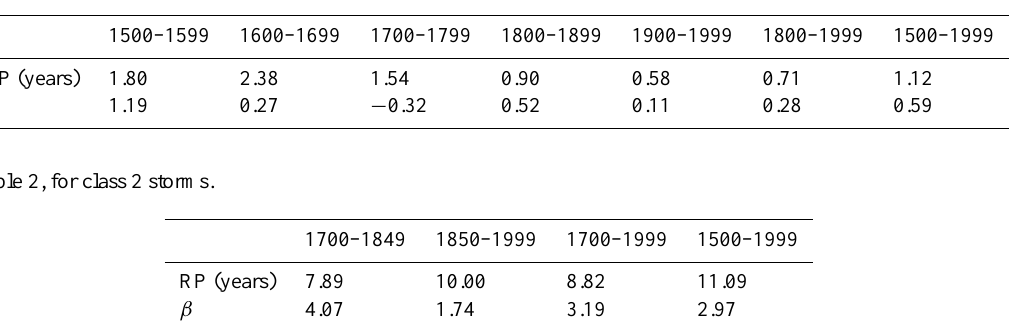
Figure 9. Clustering strength ( β ) as a function of the storm severity groupings for (a) UK and (b) Netherlands. Table 2. β for class 1 storms in the Brázdil data set, for various time periods.